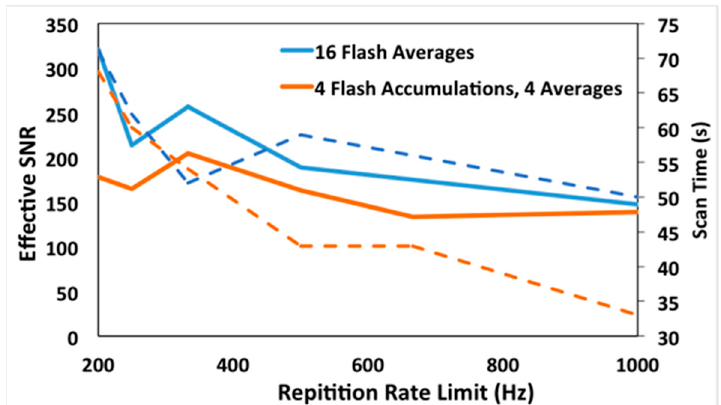
Figure A4. Plots of acquisition repetition rate versus effective signal-to-noise ratio (SNR eff ) for single flash accumulation with 16 averages for 4 flash accumulation and 4 averages settings (solid lines). Acquisition rates versus effective scan times plotted on the right axis (dotted lines).